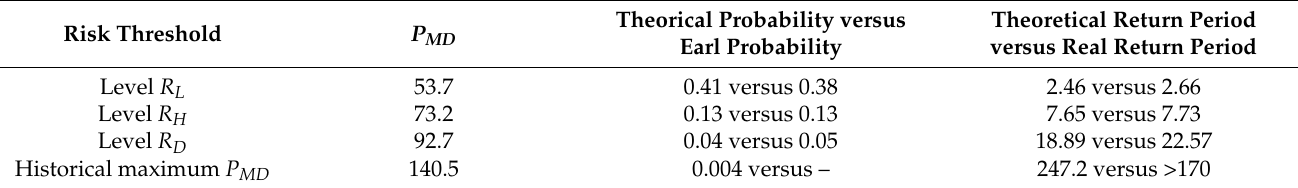
Table 2. Comparison of probability of reaching the indicated P MD value and its corresponding return period in years.